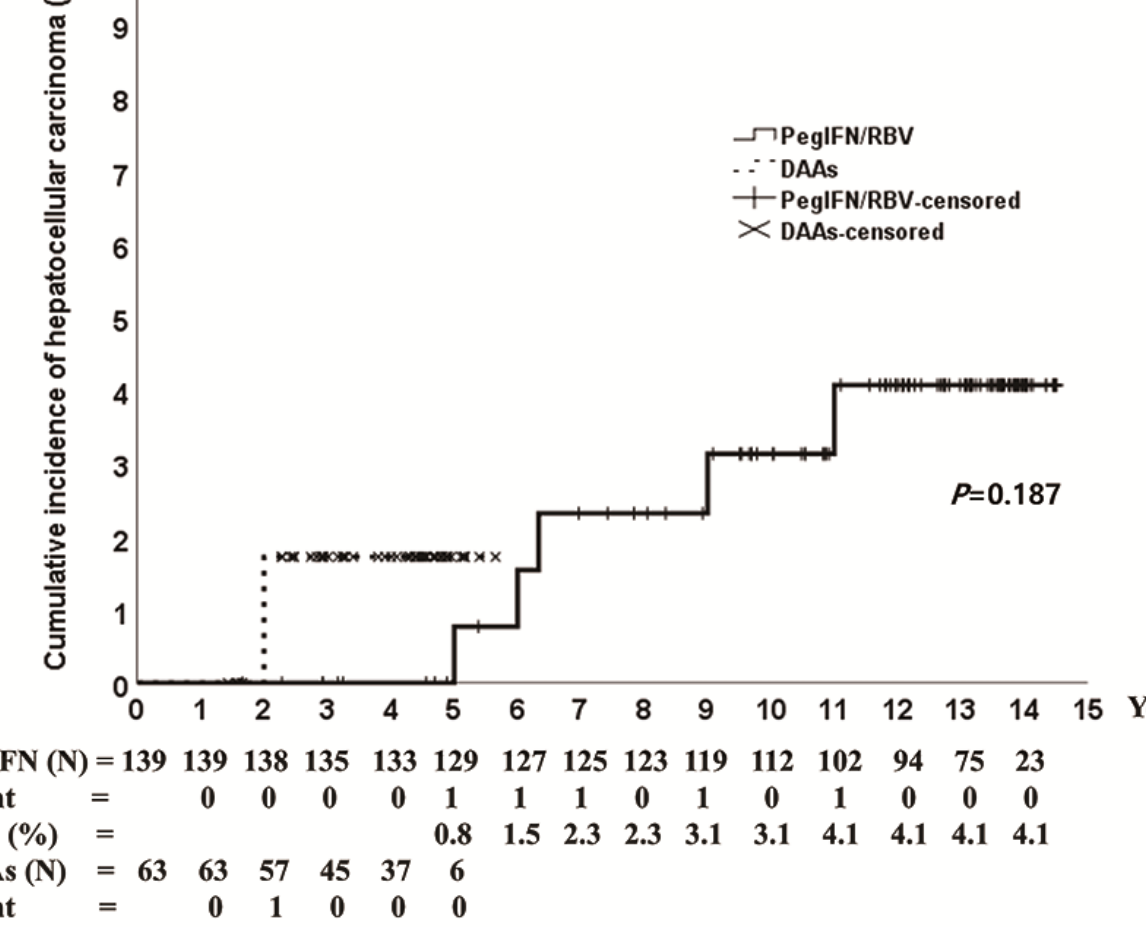
Figure 3. Cumulative incidence of hepatocellular carcinoma according to pegylated interferon plus ribavirin and direct-acting antivirals. PegIFN/RBV, pegylated interferon plus ribavirin; DAAs, direct-acting antivirals.